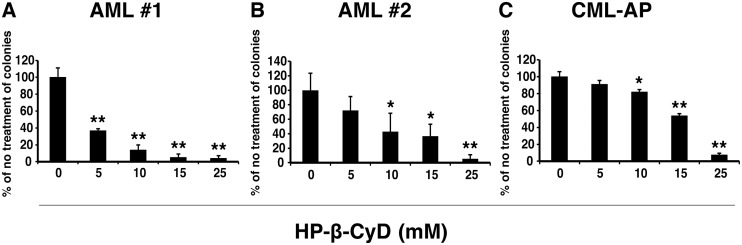
HP-β-CyD inhibits the in vitro colony-forming ability of human primary leukemic cells.Mononuclear cells (MNCs) obtained from two patients with AML and from one patient with accelerated phase CML (CML-AP) were plated in methylcellulose containing HP-β-CyD and cultured for 8–13 days. Colonies (>50 cells) were counted. Results are expressed as the percentage of colonies relative to the untreated control ± SD of three replicates. (A and B) Colony formation assays of MNCs from AML patients (FAB: M0) in the presence of HP-β-CyD. (C) Colony formation assays of MNCs from the CML-AP patient in the presence of HP-β-CyD. *P < 0.05. **P < 0.01.